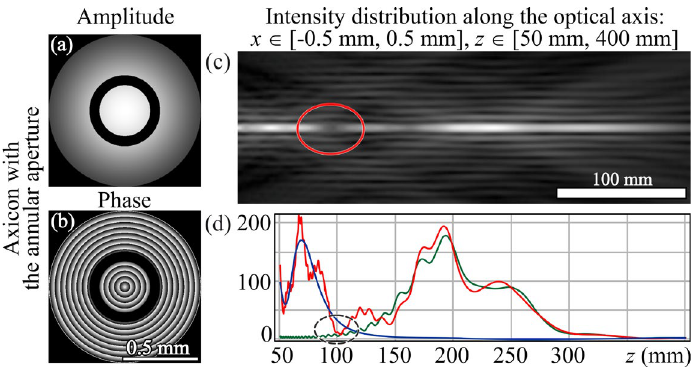
Figure 5. Simulation results of the optical bottle formation by blocking radiation using an annular screen under illumination with the Gaussian beam with σ = 1.3 mm: ( a ) amplitude and ( b ) phase at the input, ( c ) amplitude distribution along the optical axis ( x ∈ [−0.5 mm; 0.5 mm], z ∈ [50 mm; 400 mm]), ( d ) plot of intensity on the axis for the annular slots r s = 0, r e = 0.5 mm (blue color), r s = 0.7 mm, r e = 1.5 mm (green color) and for the blocking screen r s = 0.5 mm, r e = 0.7 mm (red color). The light walls of the cavity outside the optical axis are formed due to diffraction effects (see Figures 4 and 5).